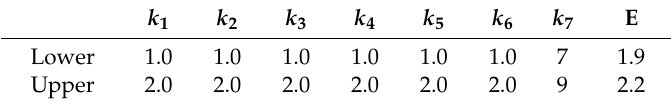
Table 6. The range of variation of the uncertainty parameters.